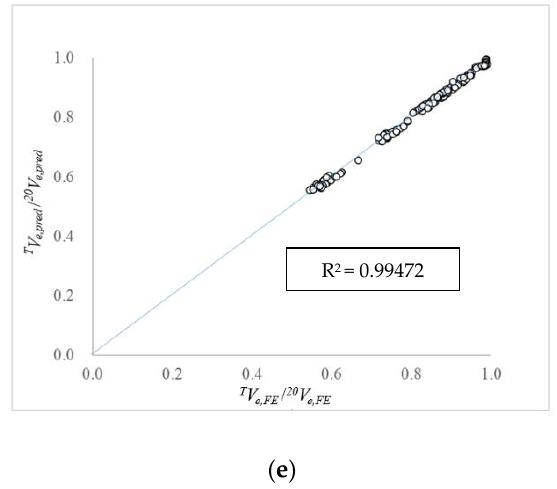
Figure 16. Training and test results of machine learning methodology for T V e / 20 V e . ( a ) T V e,pred / 20 V e,pred − T V e,FE / 20 V e,FE scatter plot of ANN_BP; ( b ) T V e,pred / 20 V e,pred − T V e,FE / 20 V e,FE scatter plot of ANN_RBF; ( c ) T V e,pred / 20 V e,pred − T V e,FE / 20 V e,FE scatter plot of SVR+CV; ( d ) T V e,pred / 20 V e,pred − T V e,FE / 20 V e,FE scatter plot of SVR+PSO; ( e ) T V e,pred / 20 V e,pred − T V e,FE / 20 V